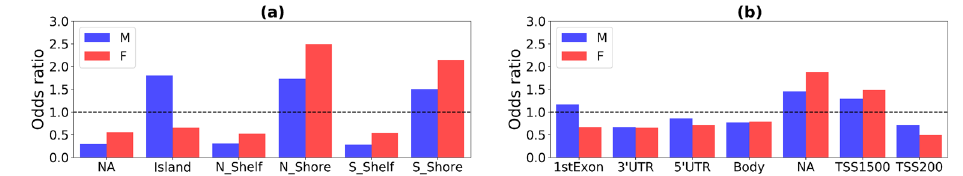
Figure 2. Enrichment (odds ratio) of genomic localizations for aVMPs calculated for males (blue) and females (red): ( a ) enrichment of genomic regions, ( b ) enrichment of genome